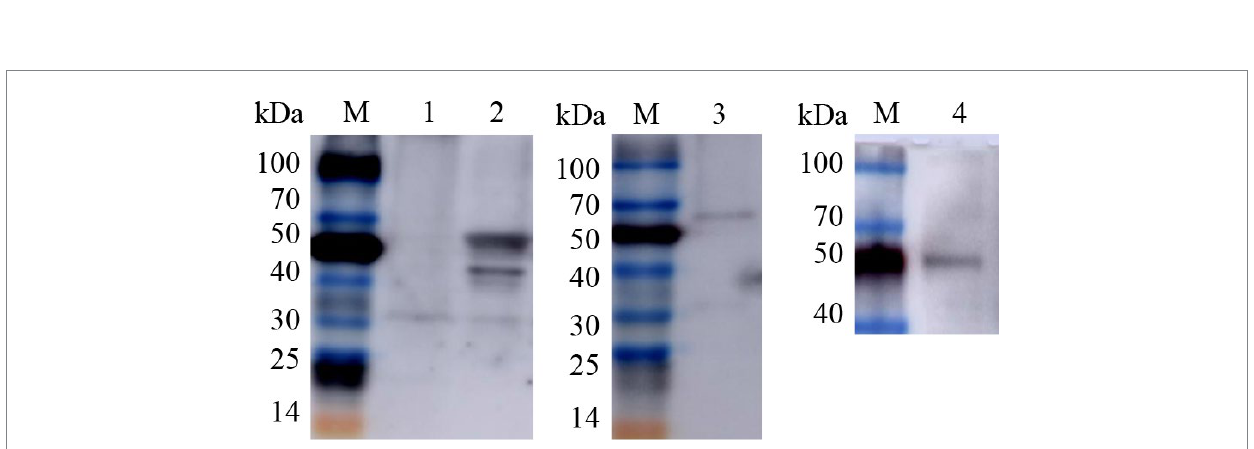
FIGURE 6 Western blot identification of recombinant baculovirus surface display particles. M, TransGen, Blue Plus Protein Marker; Lanes 1, rvAc-dual; Lane 2, Western blot (68.6 kDa/45.7 kDa); Lane 3, rvAc-Np (68.6 kDa); Lane 4, rvAc-Gn (45.7